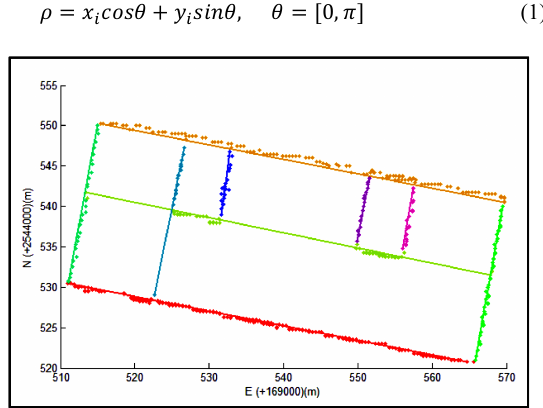
Figure 9. An example of extracted 2D lines by using Hough transform.